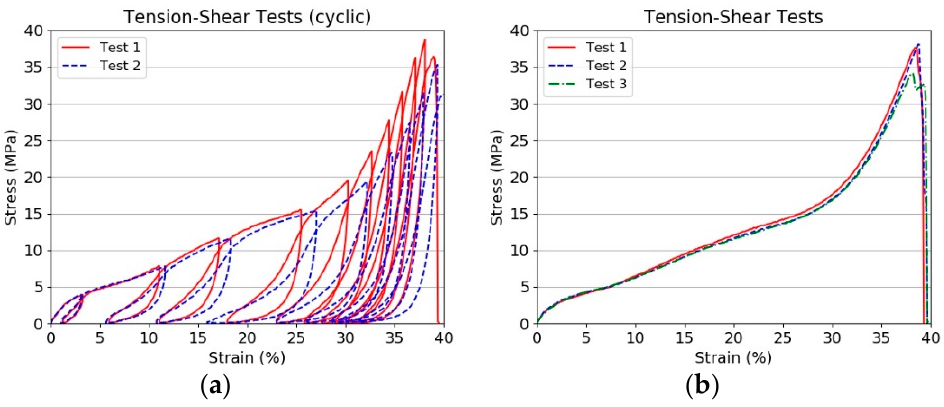
Figure 11. Tensile stress ‐ strain relationship for tension shear specimen. ( a ) Cyclic tests; ( b ) Monotonic tests.